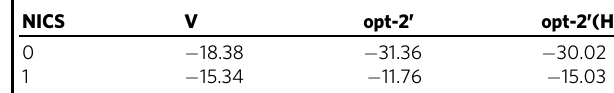
″ using 2 B 4 cores of 2 . e Bonding analysis of opt-2